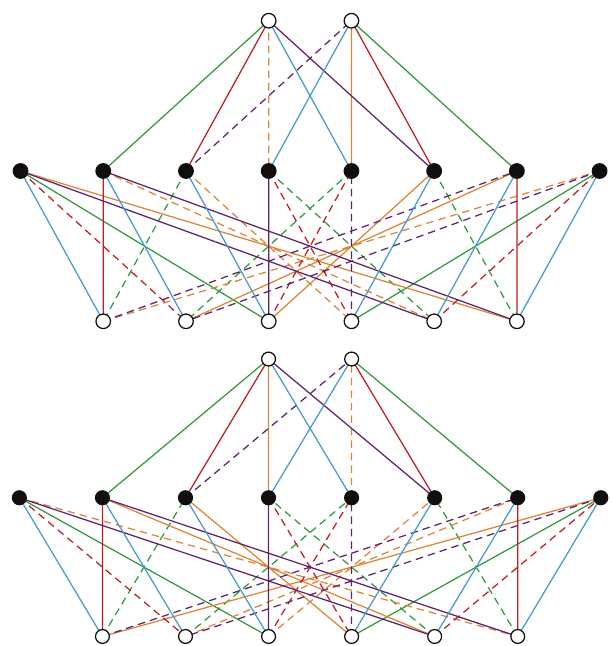
Figure 6: Two equivalent, nonisomorphic ( 5 , 1 ) Adinkras. They differ precisely in the switching state of the yellow